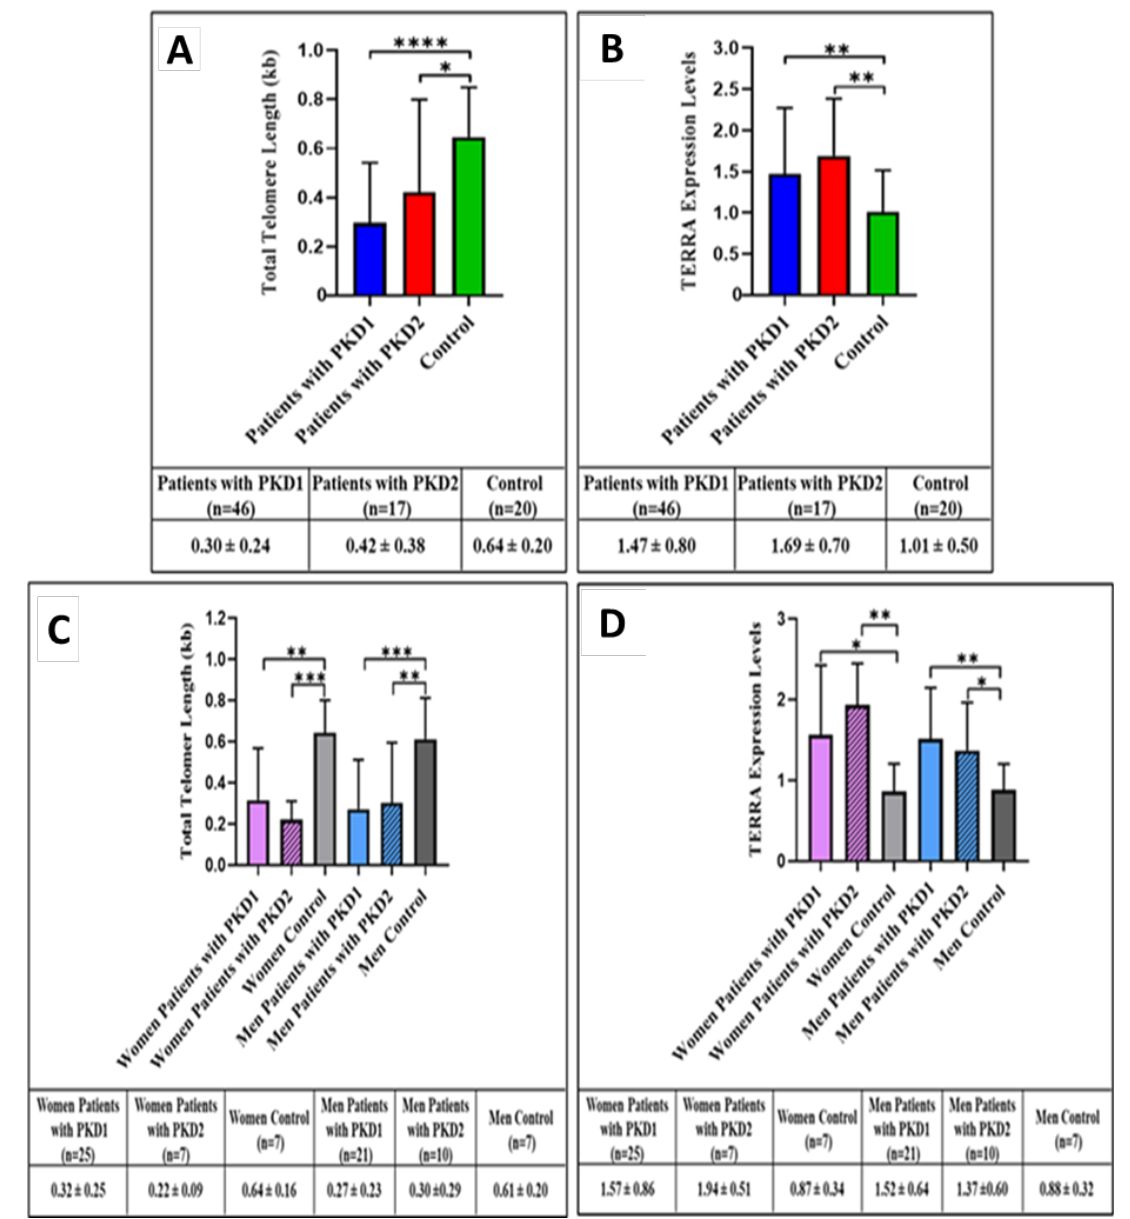
Figure 2. Telomere lengths were compared between patients carrying the PKD1 and PKD2 mutations, and the control group. The telomere length of PKD1 (**** p < 0.0001) and PKD2 patients (* p = 0.035) was found to be shorter than that of the control group. ( A ) TERRA expression levels were compared between patients carrying the PKD1 and PKD2 mutations, and the control group. Expression levels of TERRA of PKD1 (** p = 0.0066) and PKD2 patients (** p < 0.0015) were found to be increased compared to controls. ( B ) Telomere lengths were compared between women and men with the PKD1 or PKD2 mutation, and control groups by gender. The telomere length of women with PKD1 (** p = 0.0022) and with PKD2 (*** p = 0.0003) was found to be shorter than that of the control group. The telomere length of men with PKD1 (*** p = 0.0003) and men with PKD2 (** p = 0.0029) with was found to be shorter than that of the control group. ( C ) The expression levels of TERRA were compared between women and men carrying the PKD1 and PKD2 mutations, and the control groups according to gender. TERRA expression levels of female patients with PKD1 (* p = 0.0324) and PKD2 (** p = 0.0043) were found to be increased com- pared to controls. TERRA expression levels of male patients with PKD1 (** p = 0.0044) and male patients with PKD2 (** p = 0.0305) were found to be increased compared to controls. All data were plotted as mean ± standard deviation ( D ).